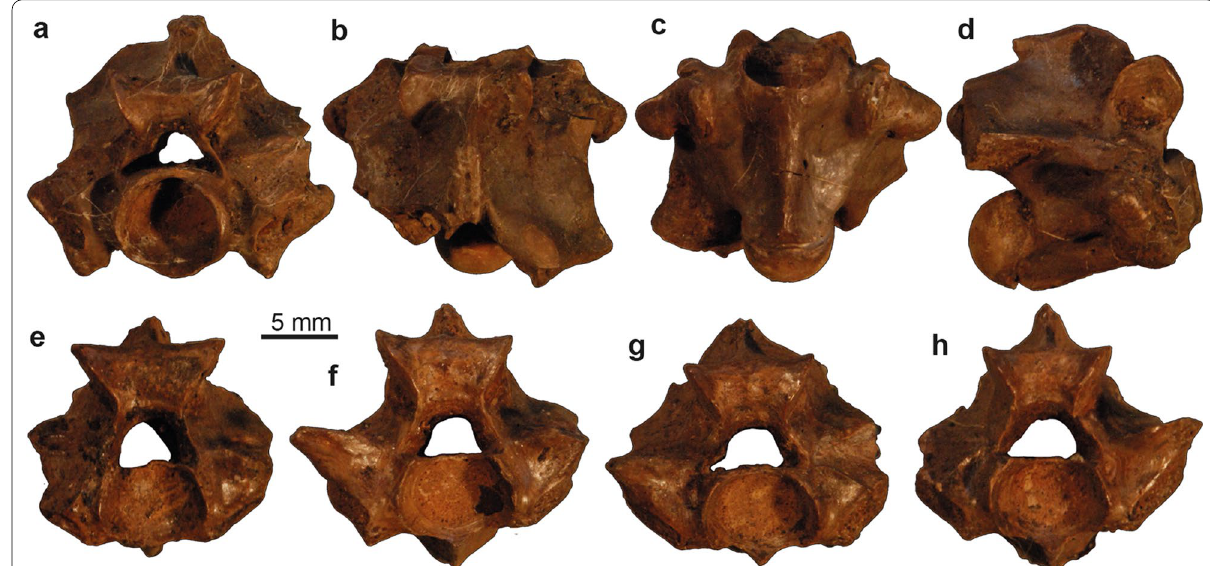
Fig. 27 Palaeopython ceciliensis from quarry Cecilie I, Geiseltal (type locality): a – d a mid- to posterior trunk vertebra (GMH Ce I-5837c-1926) in anterior ( a ), dorsal ( b ), ventral ( c ), and right lateral ( d ) views; e mid-trunk vertebra (GMH Ce I-5837d-1926) in anterior view; f mid-trunk vertebra (GMH Ce I-5837e-1926) in anterior view; g mid-trunk vertebra (GMH Ce I-5837f-1926) in anterior view; h mid-trunk vertebra (GMH Ce I-5837h-1926) in anterior view. All these specimens were originally referred to the lizard Palaeovaranus by Weigelt, 1929:fig. 2)